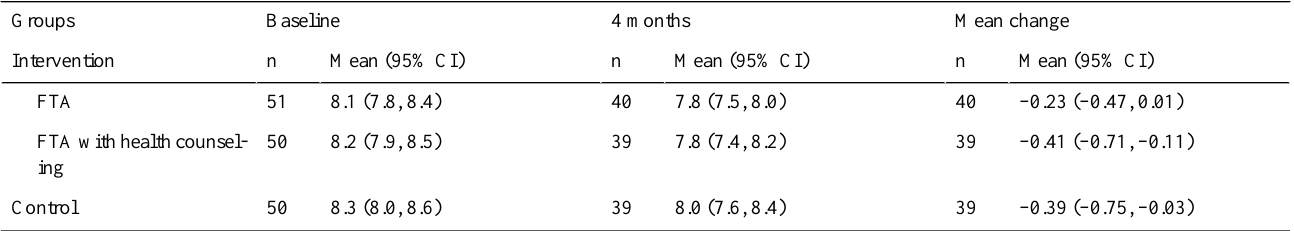
Table 4. Changes in HbA 1c between baseline and 4